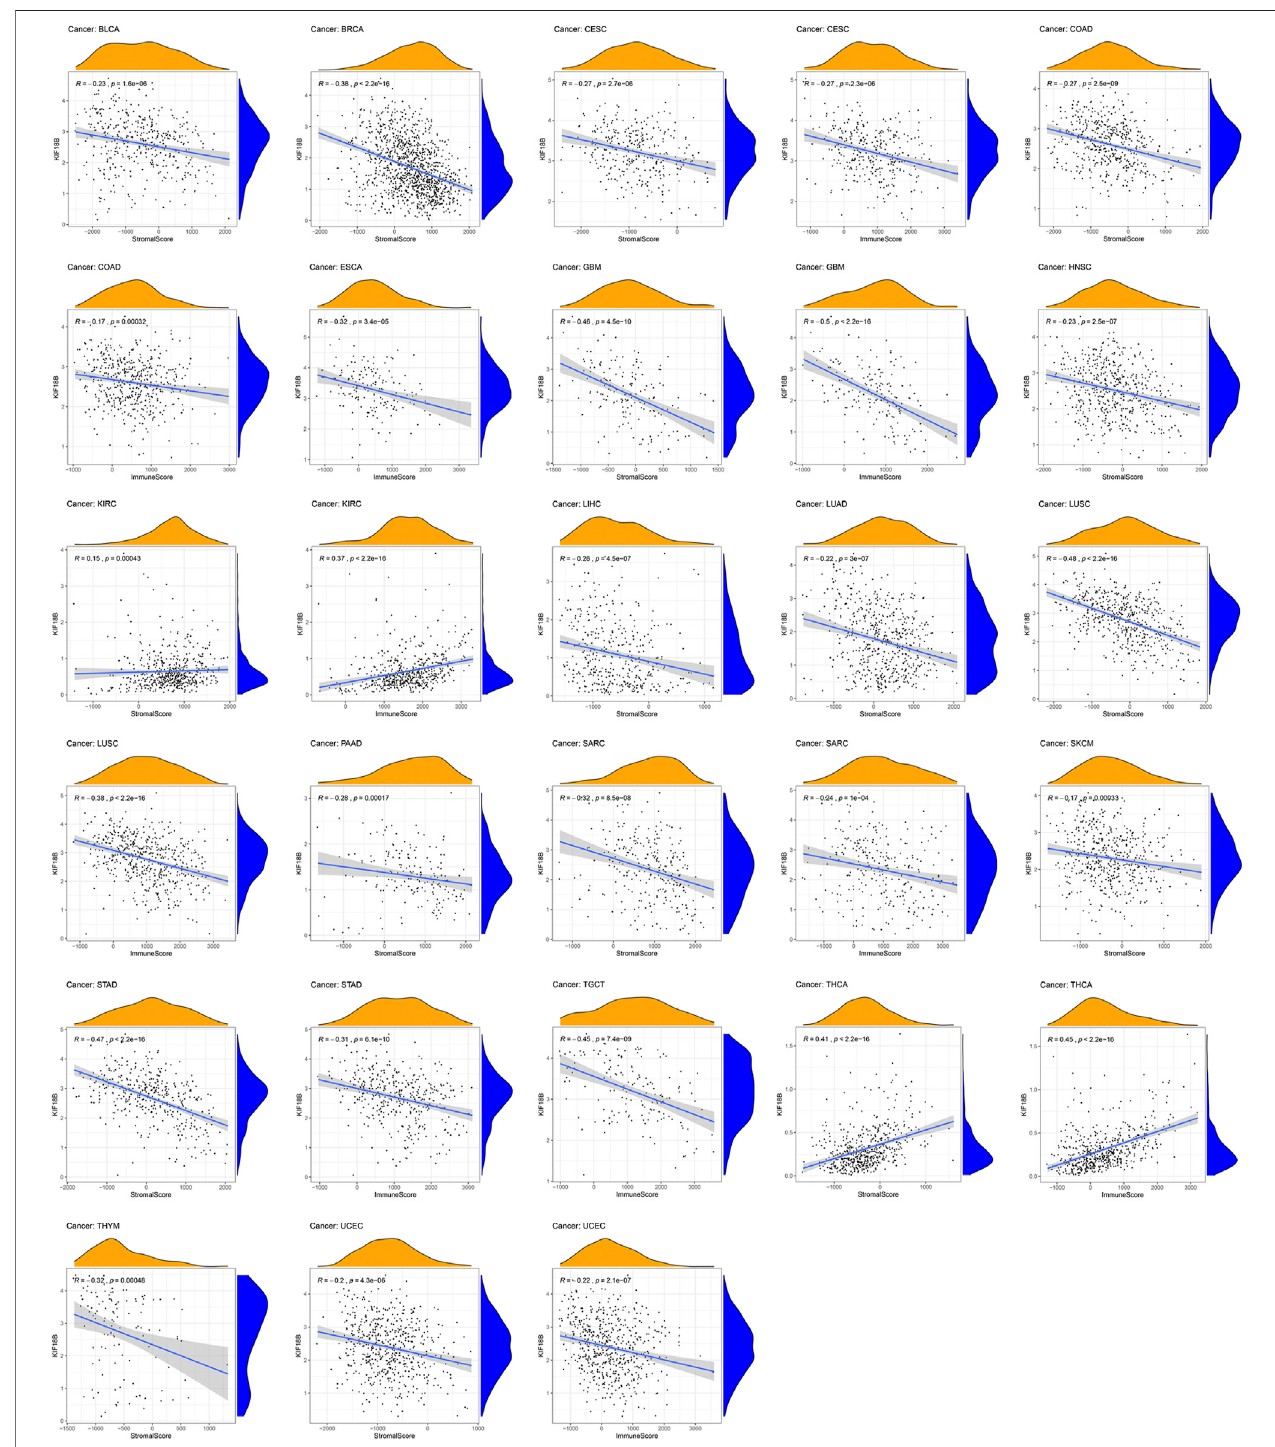
FIGURE6| ThecorrelationsbetweenKIF18B expression andthestromaland immunescoresoftumor microenvironmentsinvarious cancers.Valuesof p < 0.001 were considered and displayed.